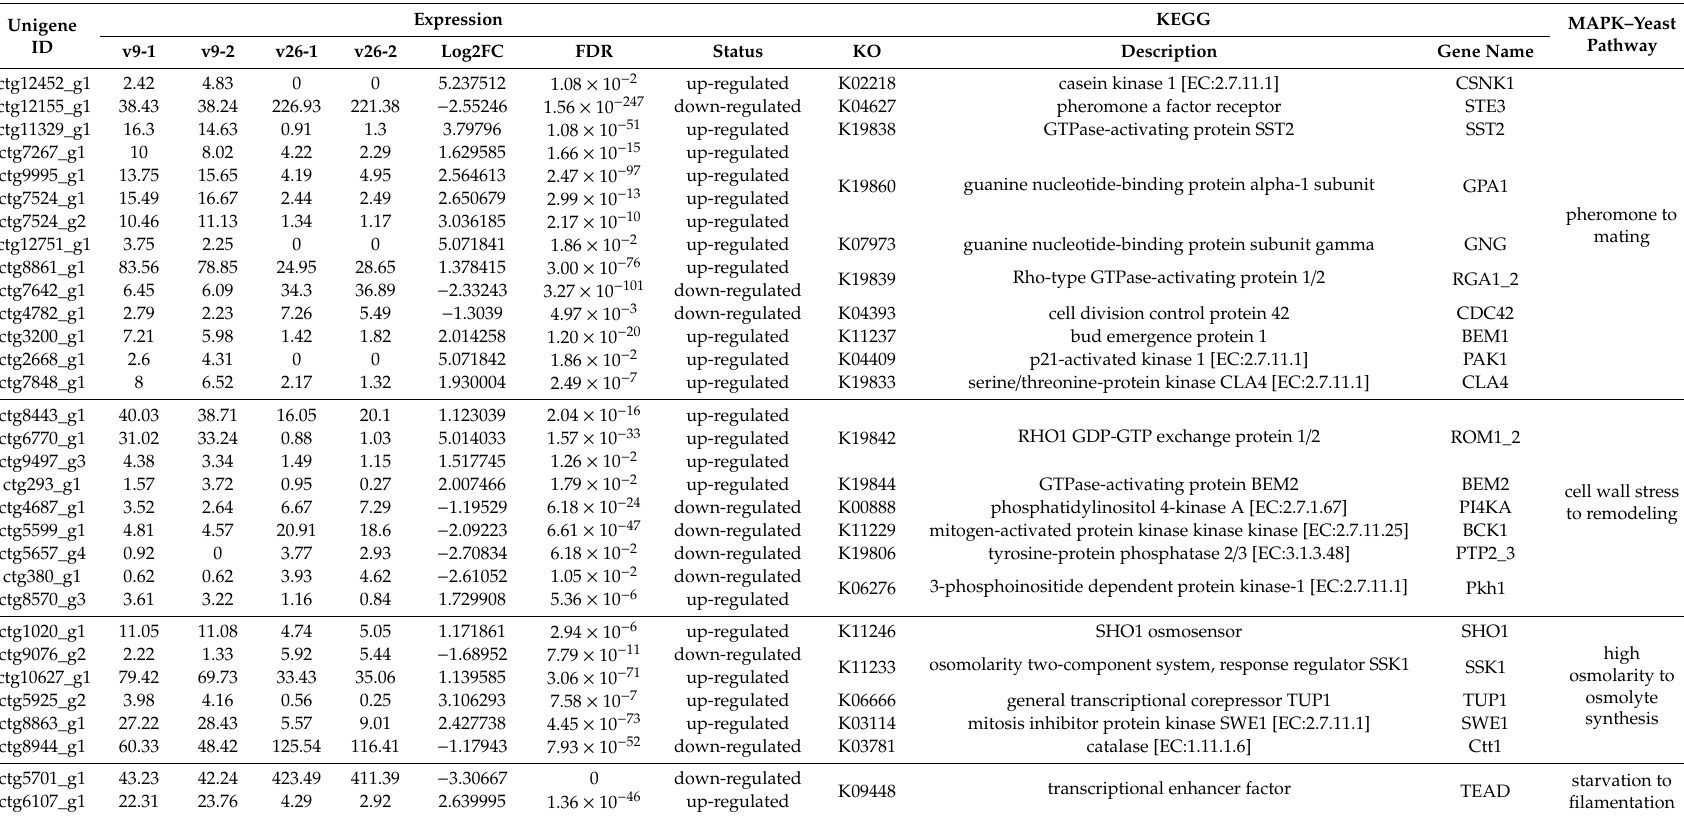
Table 3. DGEs enriched in the pathway of the MAPK signaling